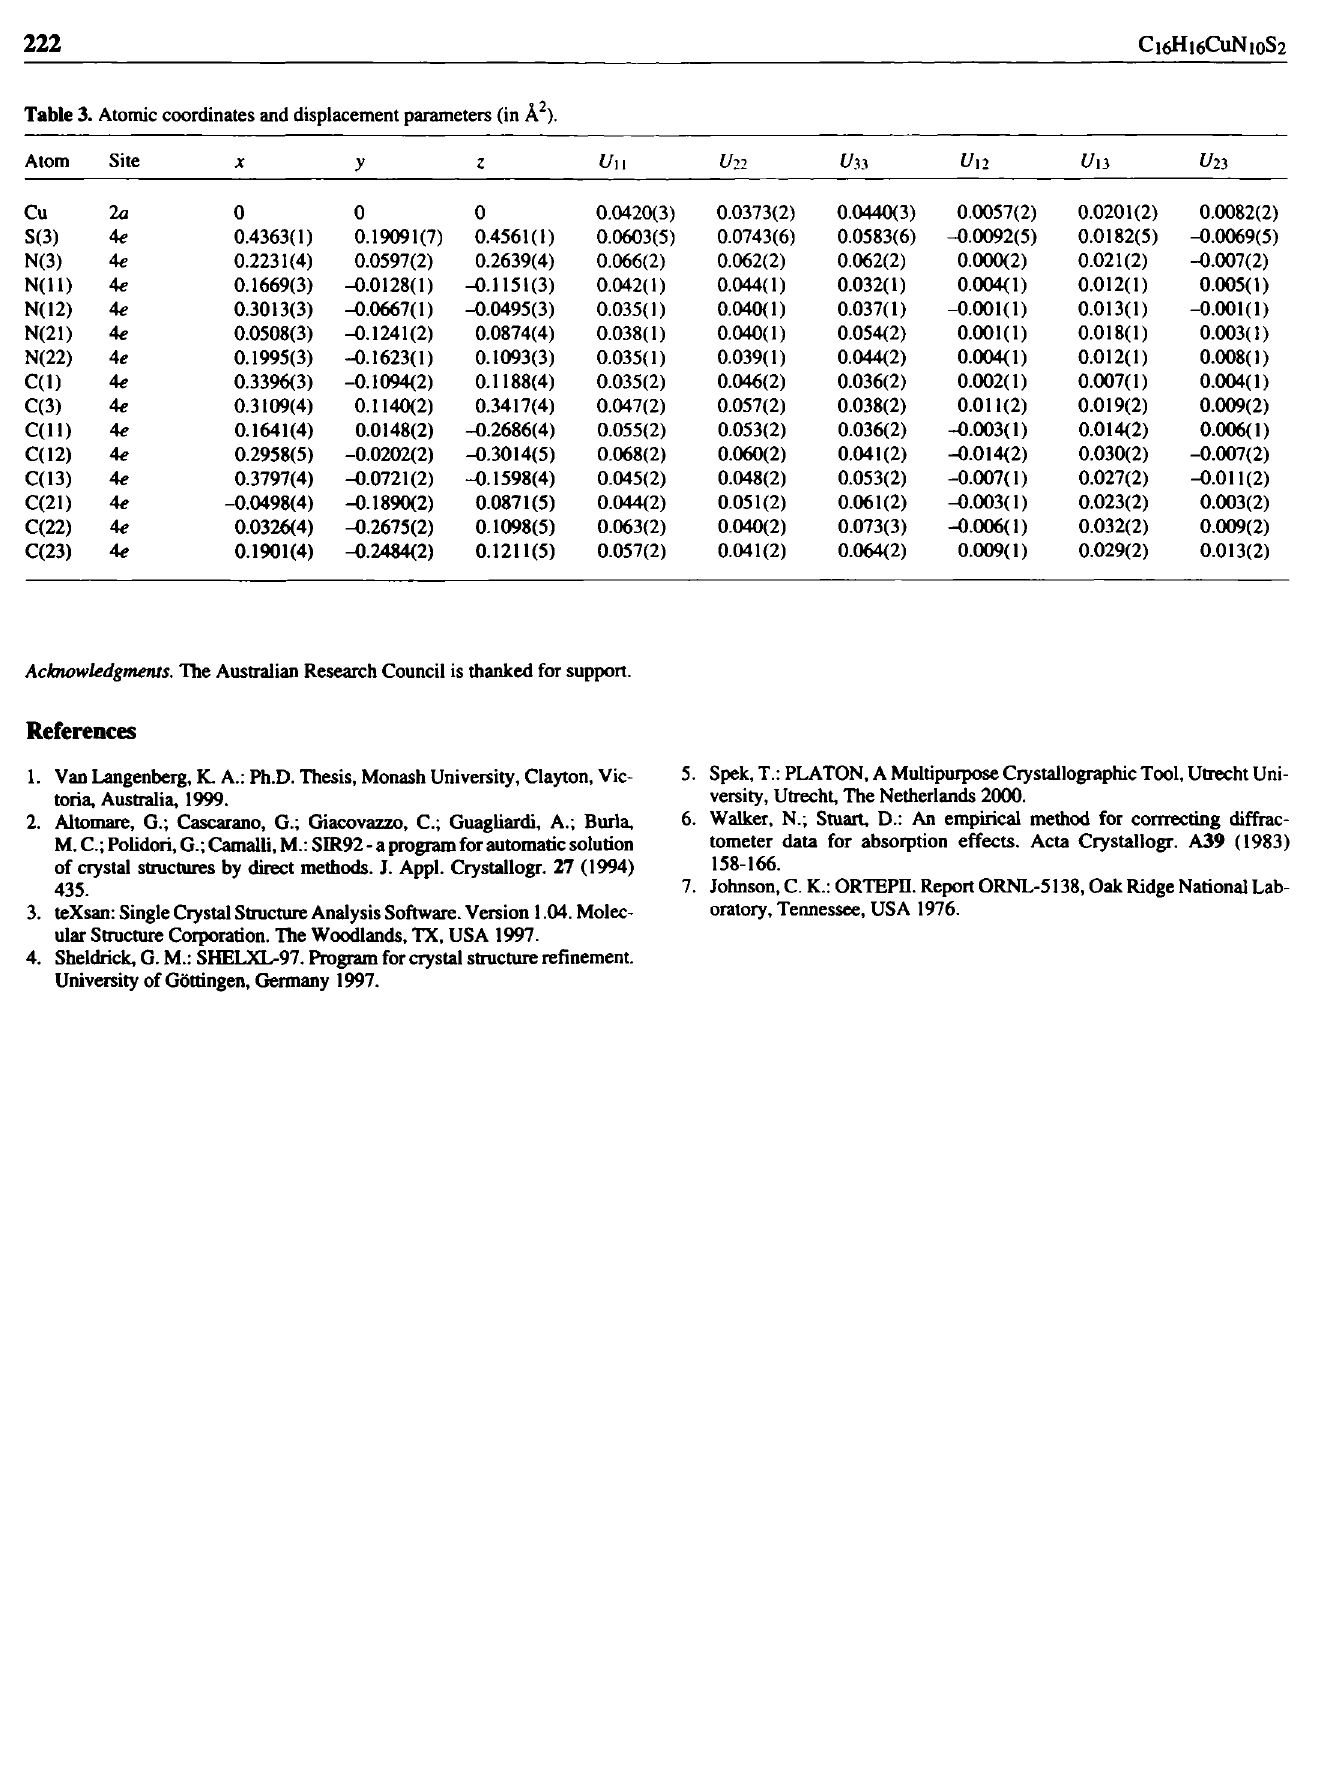
Table 3. Atomic coordinates and displacement parameters (in Ä 2